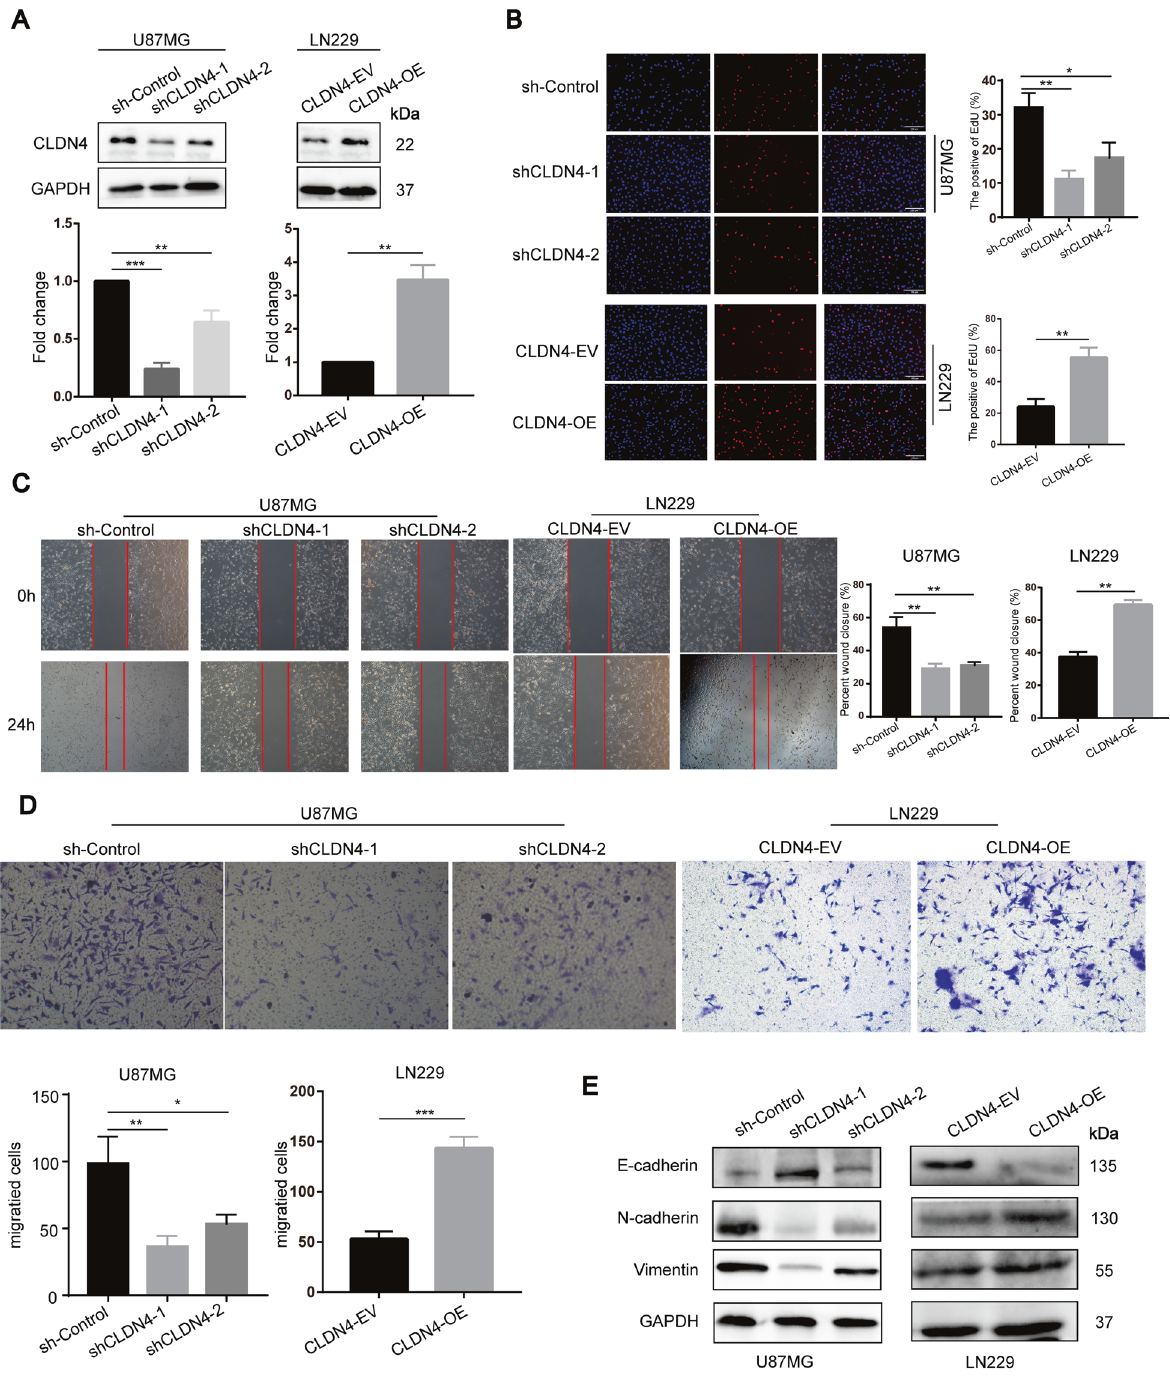
Fig. 2 CLDN4 enhances the proliferation, migration and invasion capabilities of GBM cells in vitro. A The CLDN4 expression was determined after transfecting cells with corresponding vectors by western blotting in U87 and LN229 cells. B The cell proliferation activity was examined by EdU assays. (200×). C The migration ability was determined by wound healing. D The invasion ability was determined by Transwell assay. E The EMT markers were determined by western blotting. Data are represented as the mean ± standard deviation of three independent experiments. Student ’ s t -test, compared to the Control group. * p < 0.05, ** p <